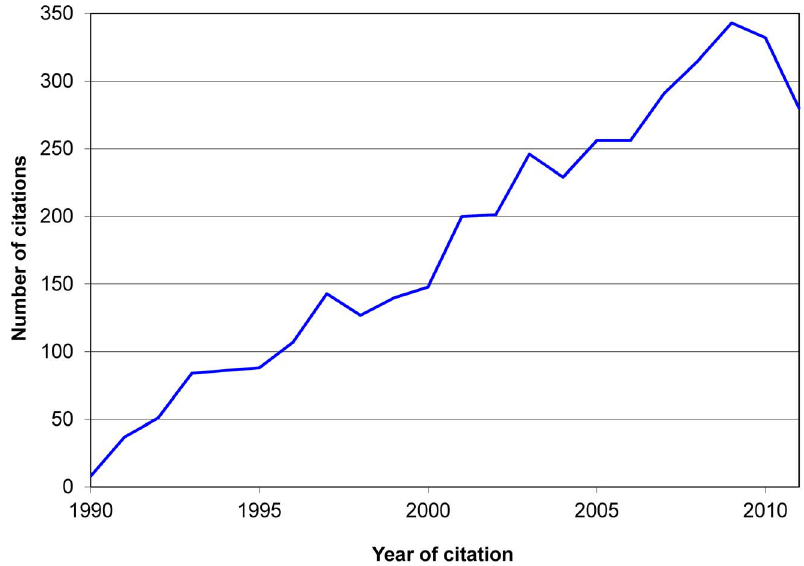
Figure 6. Citations to 2 books preferentially used in research and to 2 books preferentially used in teaching (total, 13,987 citations).